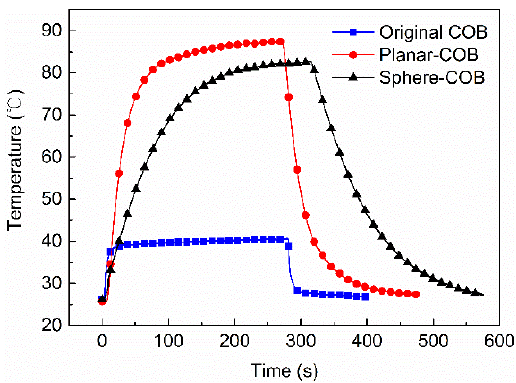
Figure 6 . Temperature curve of the original COB, sphere-COB, and planar-COB. Figure 6. Temperature curve of the original COB, sphere-COB, and